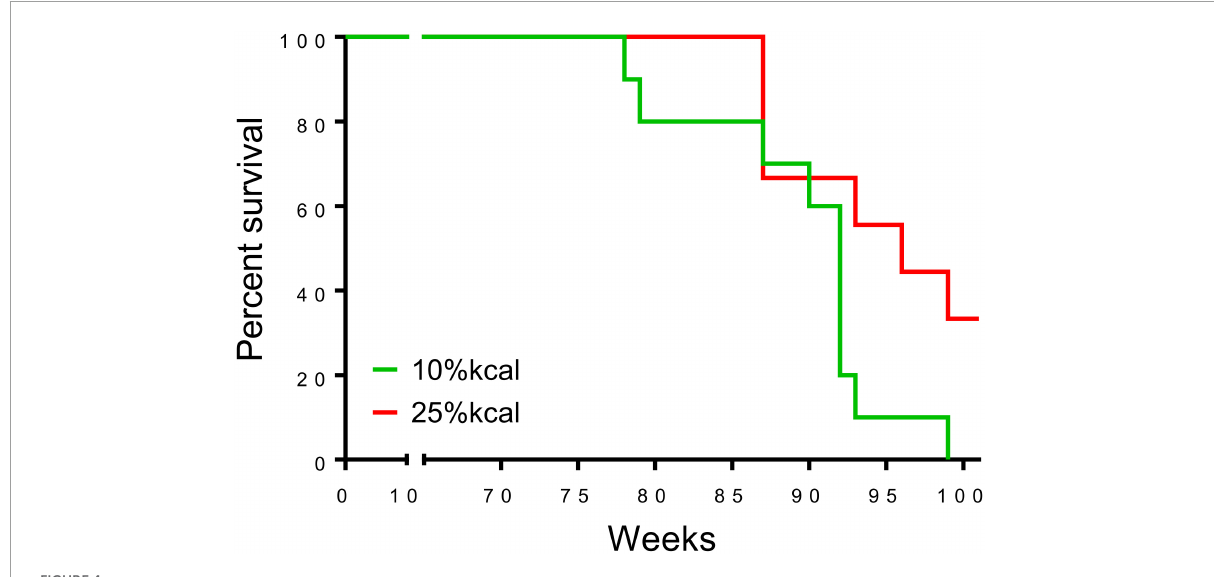
FIGURE4 Survival curve of male C57BL/6N mice ( n = 10 in each group) that have been fed with different diets. A censored death at 37 in the 25% kcal group was excluded from the analysis.